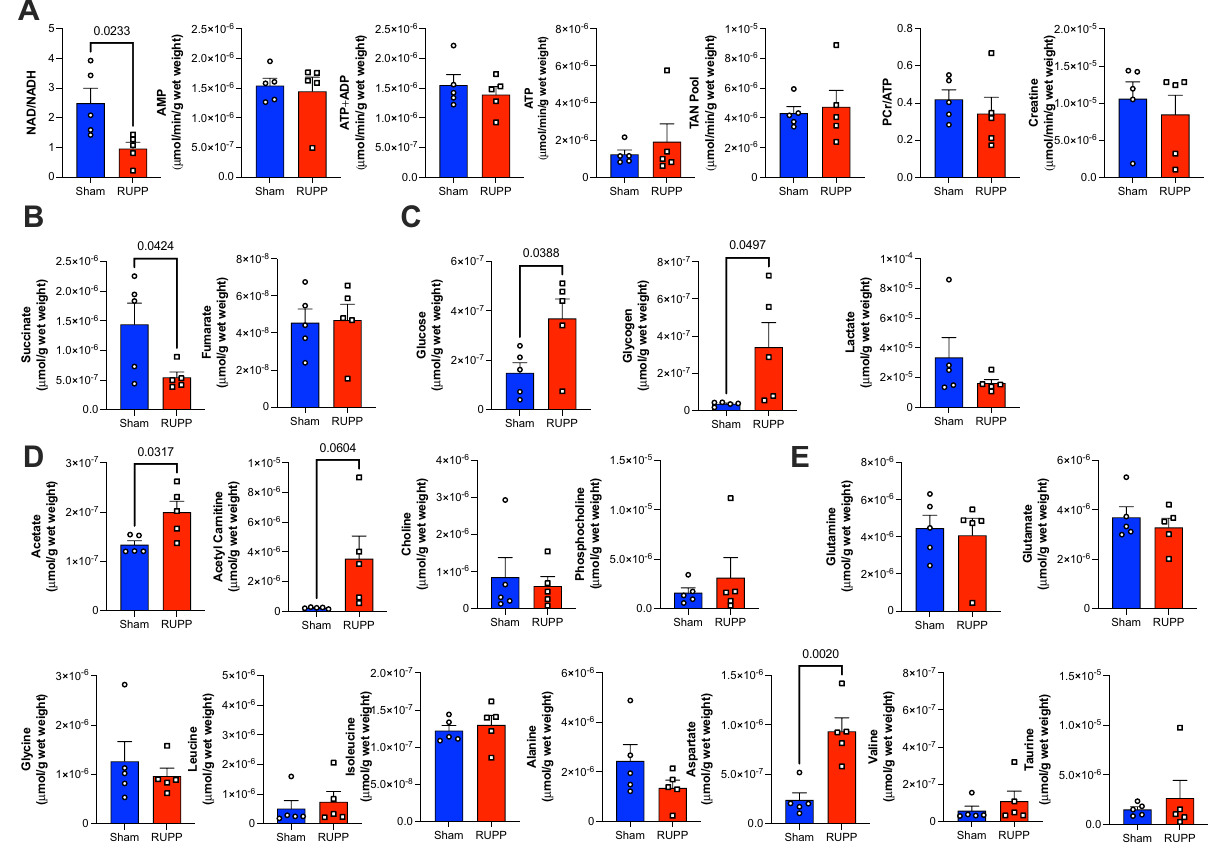
Figure 3. Metabolomic profile of RUPP model of maternal hearts. Metabolite concentrations are grouped into ( A ) Redox and Energetics ( B ) TCA cycle ( C ) Carbohydrate metabolism ( D ) Lipid metabolism ( E ) Amino acid metabolism. Two group comparison was carried out using the student T test (normally distributed data) or Mann-Whitney U test (non-normally distributed data: acetate, aspartate, NADH, lactate, leucine, valine, lactate, glutamine, choline) n = 5/group. TAN-total adenine nucleotide pool (AMP + ADP + ATP). PCr- phosphocreatine n ≥ 5; P values < 0.05 shown in individual